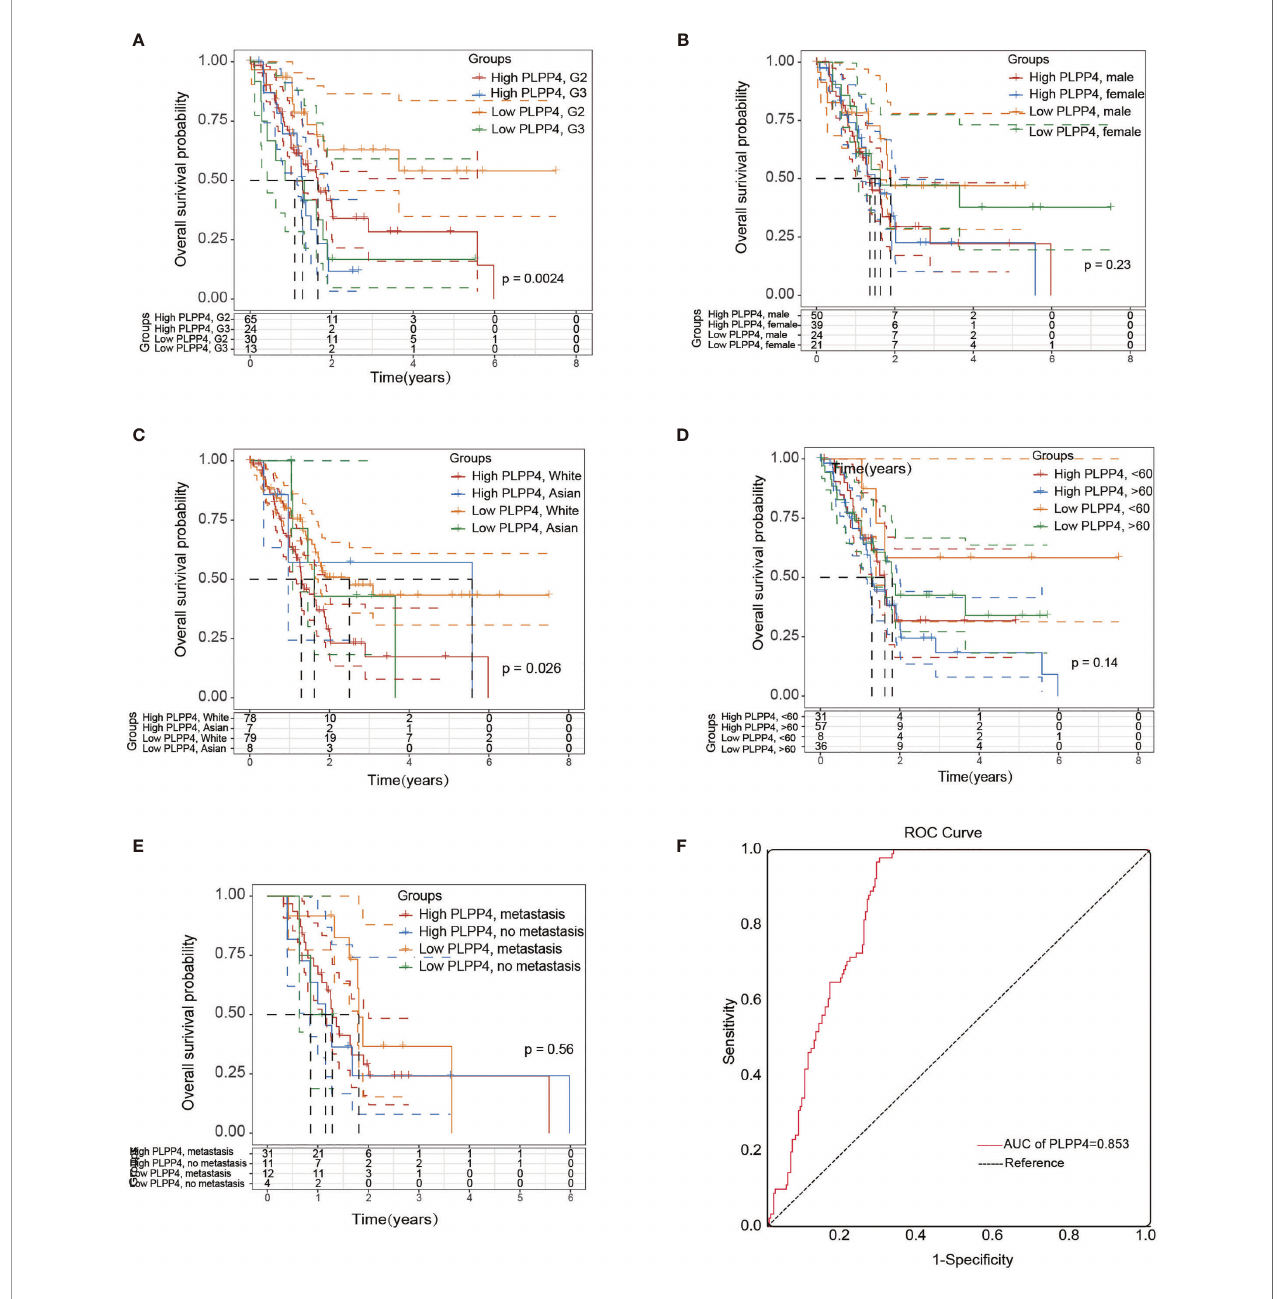
FIGURE 7 | Over survival and ROC analysis of PLPP4 signature risk score in PAAD. (A – E) In fl uence of grade, gender, race, and metastasis on over survival with high or low PLPP4 expression. (F) ROC analysis of the sensitivity and speci fi city of the prognosis prediction based on overall survival. AUC, area under the ROC